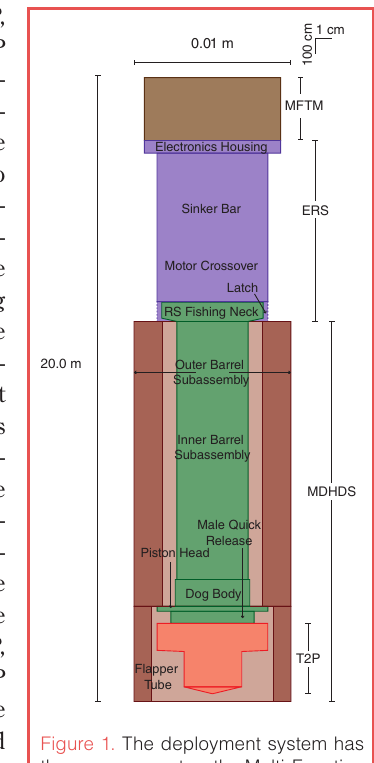
Figure 1. The deployment system has three components—the Multi-Function Telemetry Module (MFTM), the Electronic RS (ERS), and the Motion Decoupled Hydraulic Delivery System (MDHDS)—and the attached tool (in this case the T2P penetrometer). The MFTM is attached directly to the electric wireline and is in turn attached to the ERS. The MDHDS is composed of an Outer Barrel (Brown) and an Inner Barrel (green). The top of the Inner Barrel is capped by the RS Fishing Neck. The pore pressure penetrometer (red) is shown in this example as the T2P, but the SET-P or SET can also be